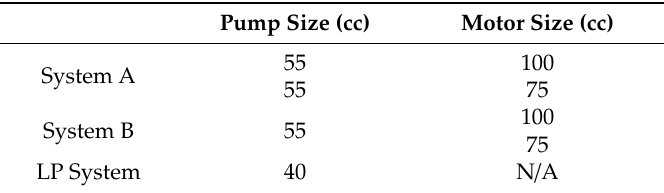
Figure 9. Reference system hydraulic schematic. Table 1. Reference system pump and motor